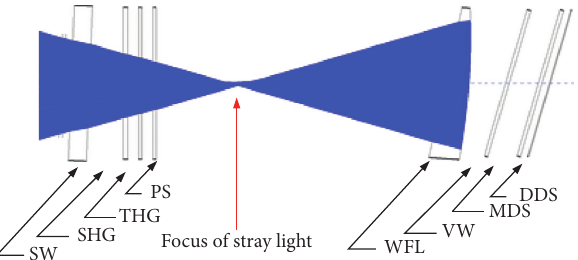
Figure 7: The result of first-order stray light reflected by WFL. The first-order stray light focus of the focusing lens is located between the frequency conversion module and the focusing module and is far away from the optical elements and structural parts.